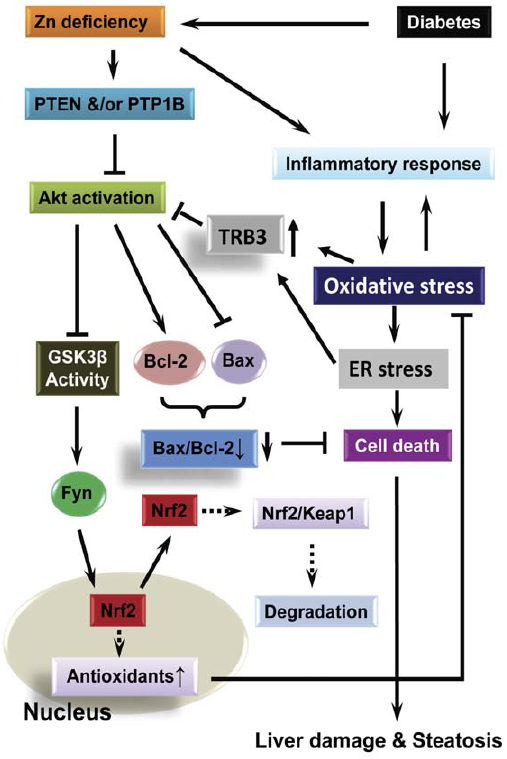
Figure 8. Possible mechanism for hepatic damage induced by diabetes and Zn deficiency. Both Zn deficiency-induced PTEN/ PTP1B activation and diabetes-increased TRB3 expression via induction of oxidative stresses and ER stress inhibit the activation of Akt, which in turn increase GSK3 b activity, leading to Fyn-nuclear accumulation that stimulates Nrf2 exporting to cytosol where to be degraded. Down- regulation of Nrf2 activity leads to the decrease in antioxidants, which cause hepatic oxidative stress, inflammation, cell death, damage, and steatosis.